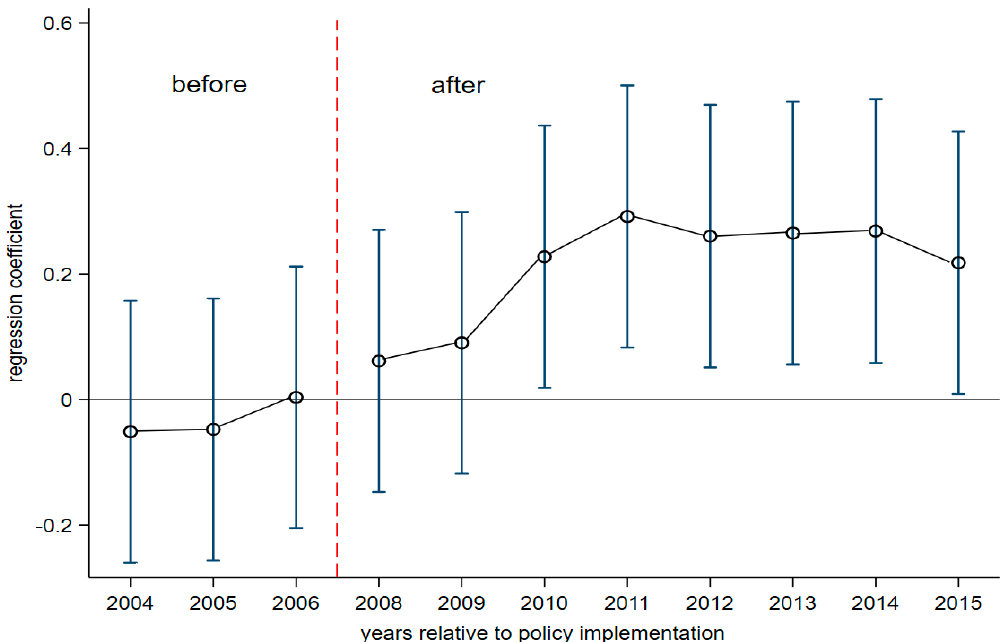
Figure 2. Dynamic effect of differences-in-differences (DID) model. Notes: The parameter estimates Figure 2. Dynamic e ff ect of di ff erences-in-di ff erences (DID) model. Notes: The parameter estimates (dots) and corresponding 95% confidence intervals (line) based on model (17). (dots) and corresponding 95% confidence intervals (line) based on model